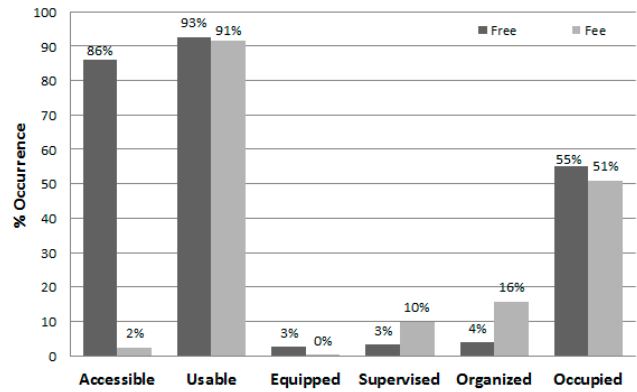
Figure 7. Observed characteristics of free ( n = 5856 area visits) and fee-charged ( n = 2528 area visits) park facilities.